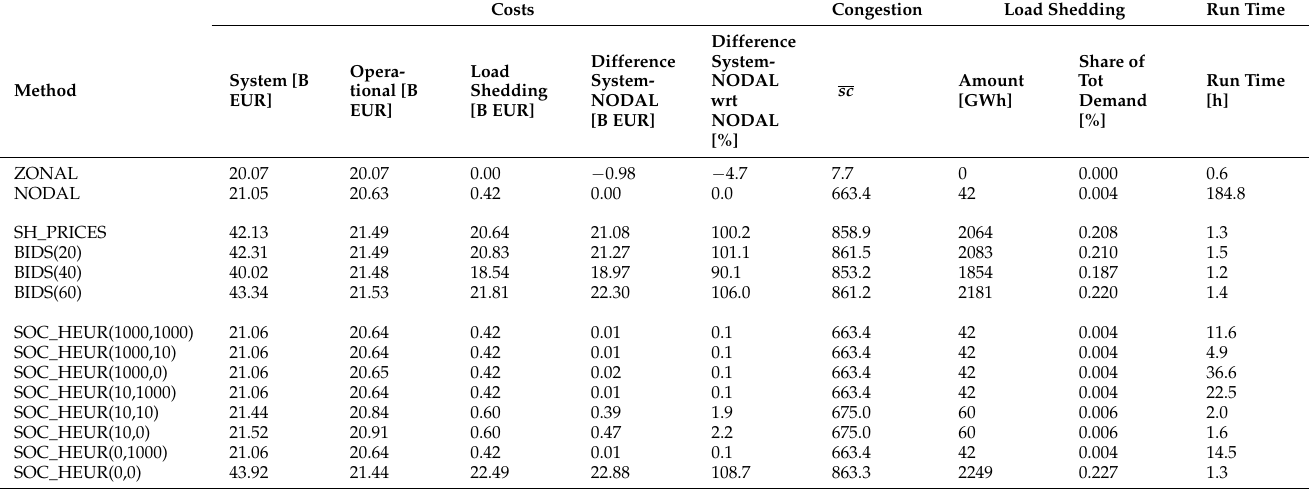
Table 1. Results overview for the short-time horizon benchmark with transmission capacity factor β = 0.7. Reported are for the different methods: the total system costs, which are made up of operational costs (i.e., power generation costs) and load shedding costs, the difference between NODAL and the respective method in absolute amount and relative to the total system costs of NODAL ; the average system congestion ( sc ); the total amount of load shed and the share of this amount with respect to the total load; and the run